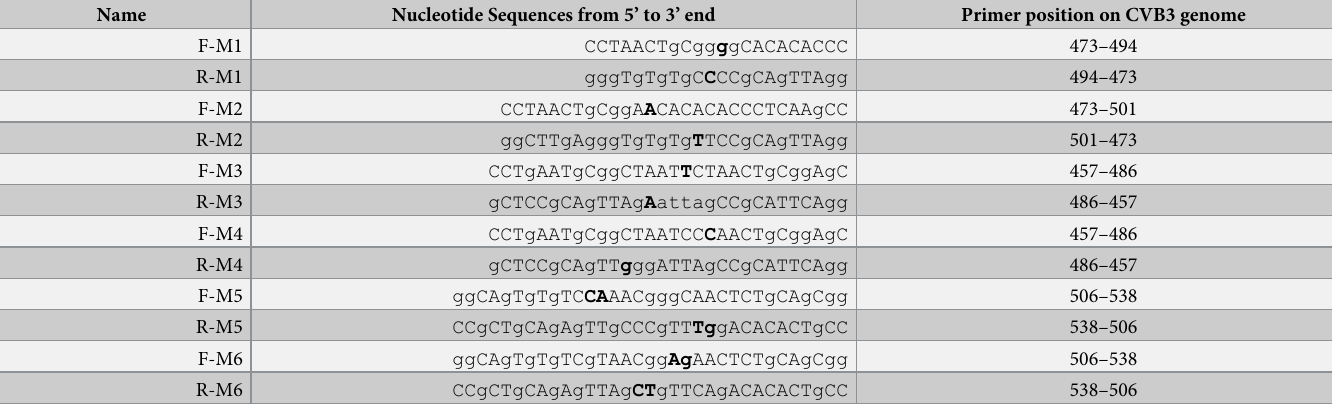
Table 1. Primer sequences used to produce RNA IRES Mutants (M1-M6) by the Site-directed mutagenesis method.